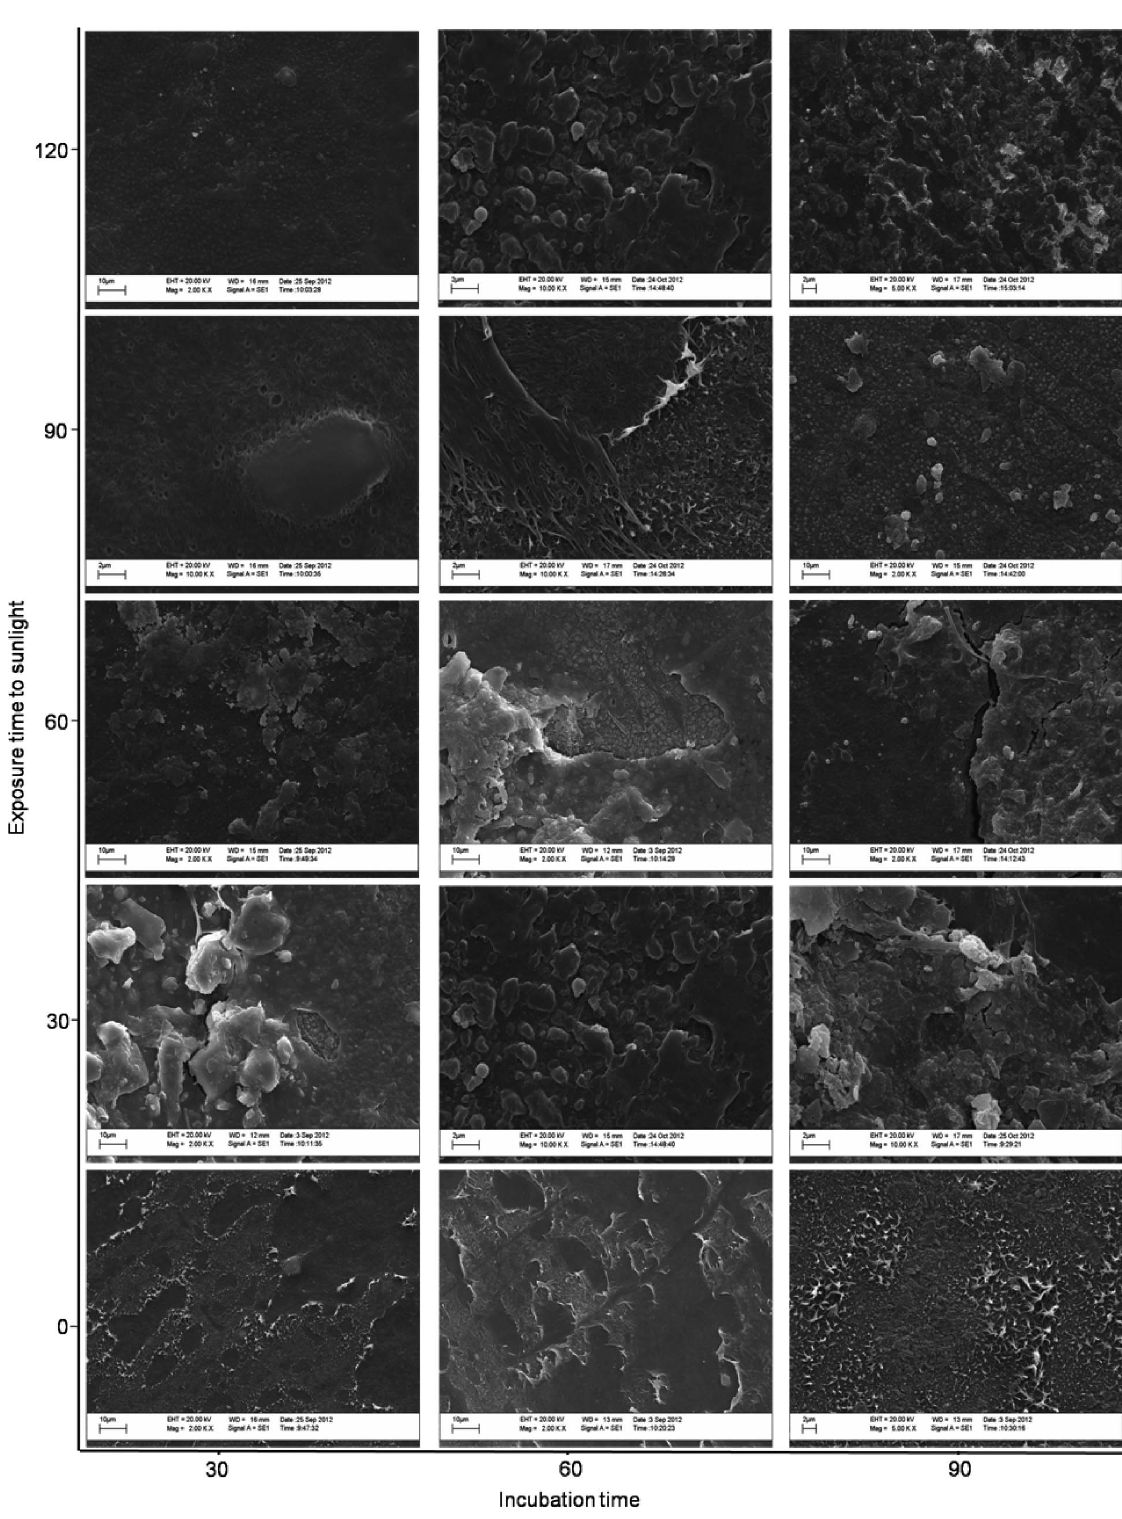
Figure 7. Scanning electron microscopy of oxo-biodegradable plastic before and after 120 days of sunlight and after 30, 60 and 90 days of incubation with Pleurotus ostreatus